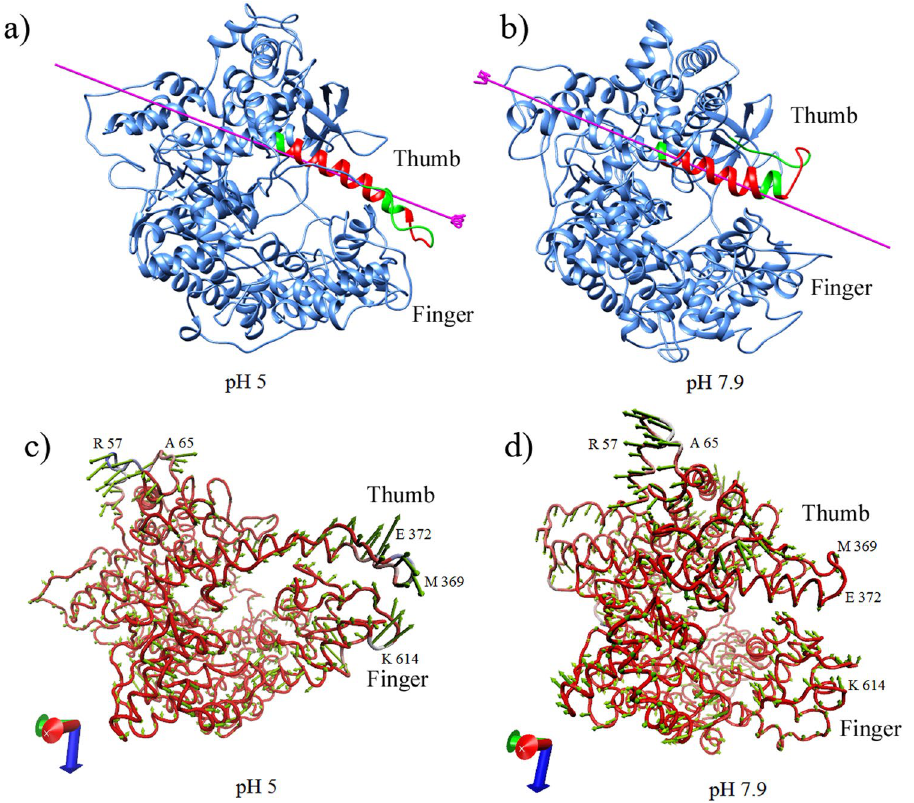
Figure 4. Domain motion analysis showing thumb sub-domain movement of T7RNAP as it transitions from pH 5 ( a ) to pH 7.9 ( b ) as identified by Dyndom. The hinge regions are colored red and the moving domains are colored green. The direction of movement along the hinge axis is depicted by the pink arrow. Porcupine plots showing prominent motions with directions at ( c ) pH 5 and ( d ) pH